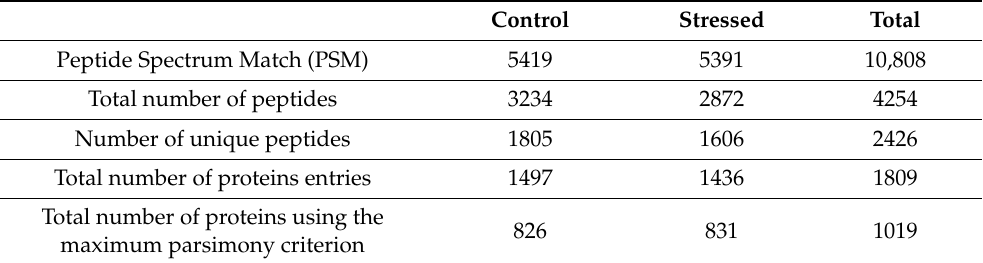
Table 2. Absolute numbers of all peptides and proteins identified via proteomics analysis in the leaves of young oil palm plants submitted to salinity stress. Control Stressed